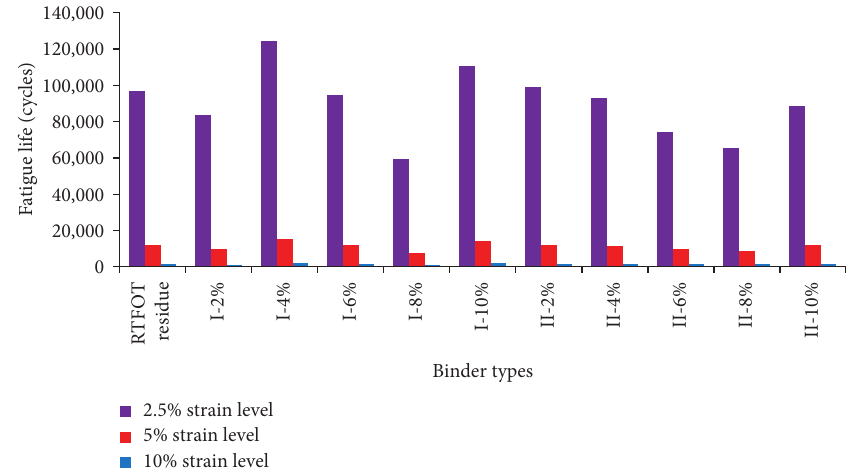
Figure 10: Effects of the rejuvenators and strain levels on fatigue